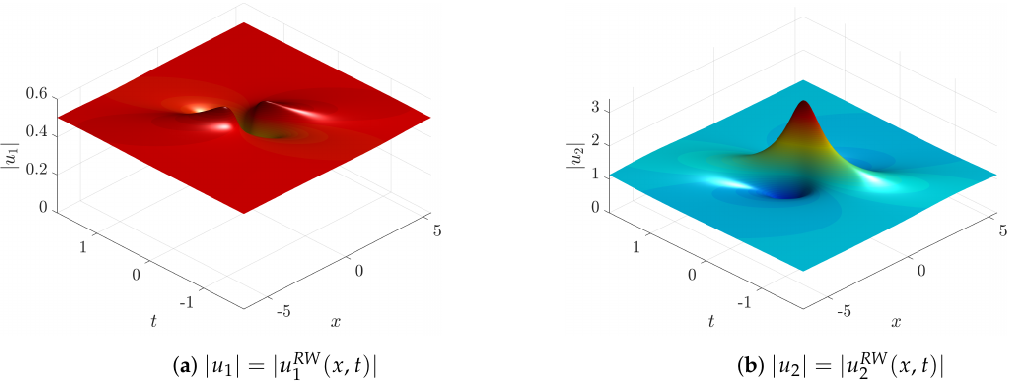
Figure 9. RW solutions corresponding to the spectrum 1 G 1 B 1 L . q = 1, s 1 = 1, s 2 = − 1 (mix), r = 15, p = − 13.45 ( a 1 = 0.88034, a 2 = 3.7716); λ c = 0.5433 + 3.6917 i , c = c 2 = 0, c 1 = 1, ( x , t ) | / a = 2.0602, max | u RW ( x , t ) | / a = 2.9987. max | u RW 2 1 2 1